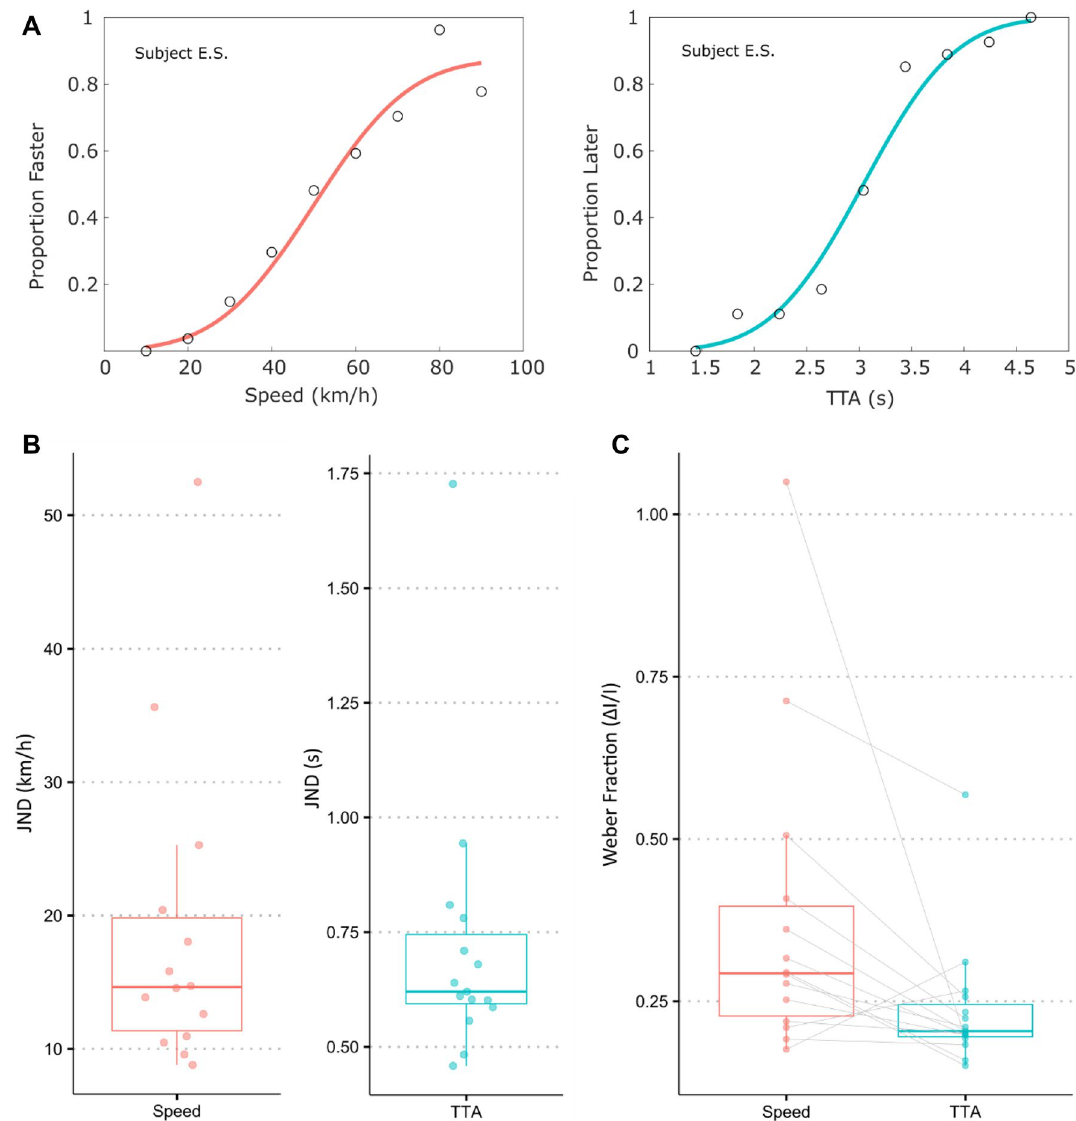
Figure 3. Example of psychometric functions of one participant, JNDs and Weber fractions. ( A ) The left panel shows the proportion of trials the exemplar participant judged the comparison vehicle as faster than the standard vehicle as a function of vehicle speed. The right panel shows the proportion of trials the exemplar participant judged the comparison vehicle as arriving later as a function of vehicle time-to-arrival. The proportion of “later” responses was calculated from the participant’s “earlier” responses and plotted to ease comparison. ( B ) Shows JNDs of all participants in the speed discrimination task (left panel; N = 14) and time- to-arrival discrimination task (right panel; N = 15). ( C ) Shows the Weber fractions for speed and time-to-arrival discrimination. Crossbars indicate median values. Whiskers depict the 1.5 × interquartile